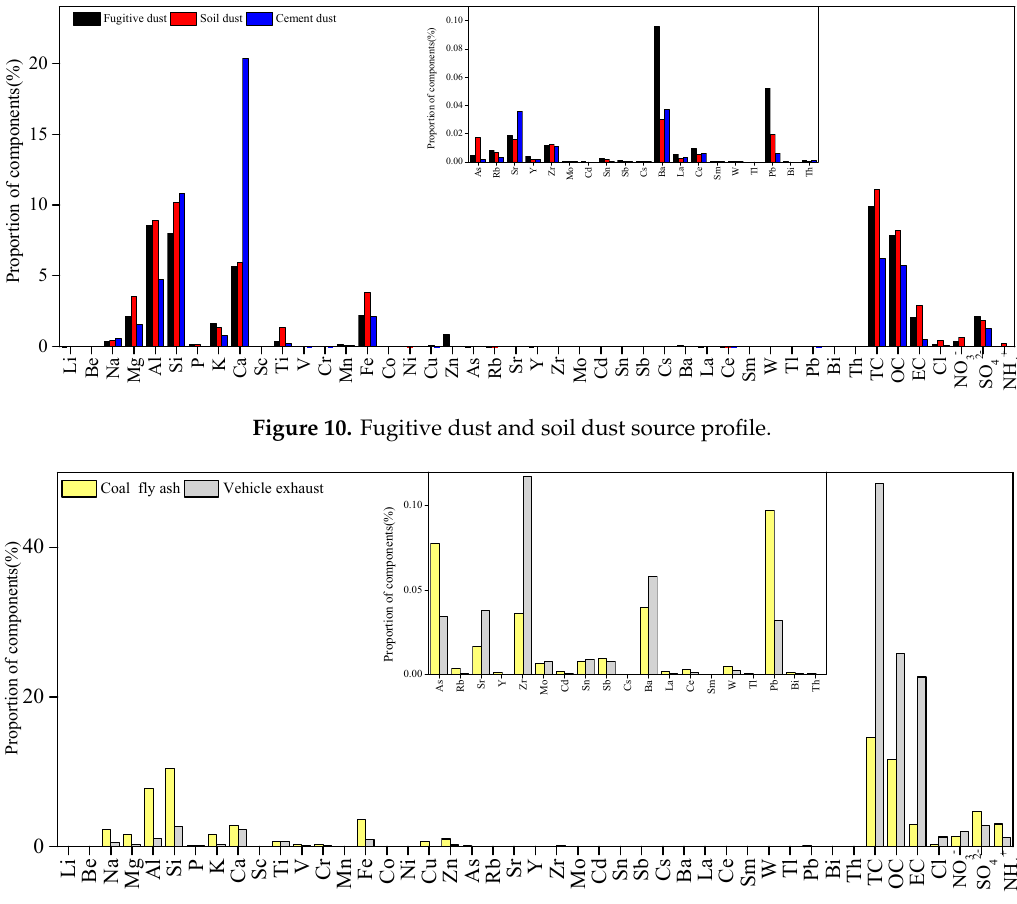
Figure 11. Coal fly ash and vehicle exhaust source profile.